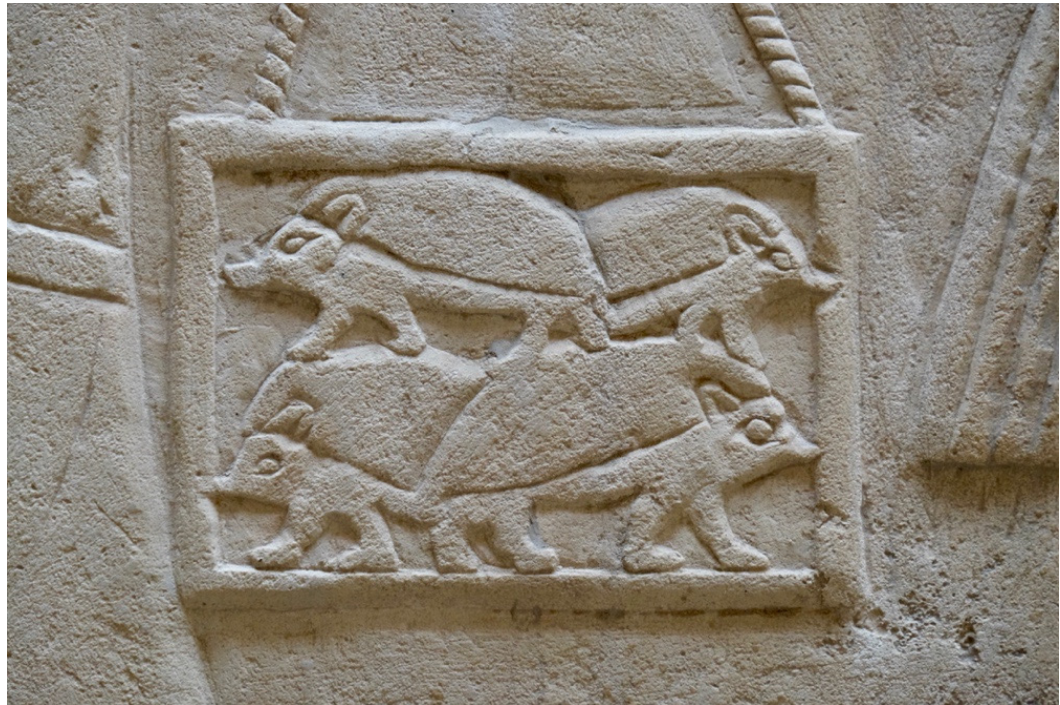
Figure 8. Detail of four live hedgehogs inside a small cage with a coiled rope handle, carried by a male offering bearer. West wall of room two in the 6th Dynasty tomb of Neferseshemptah, Saqqara. Photograph by author (January 2019).